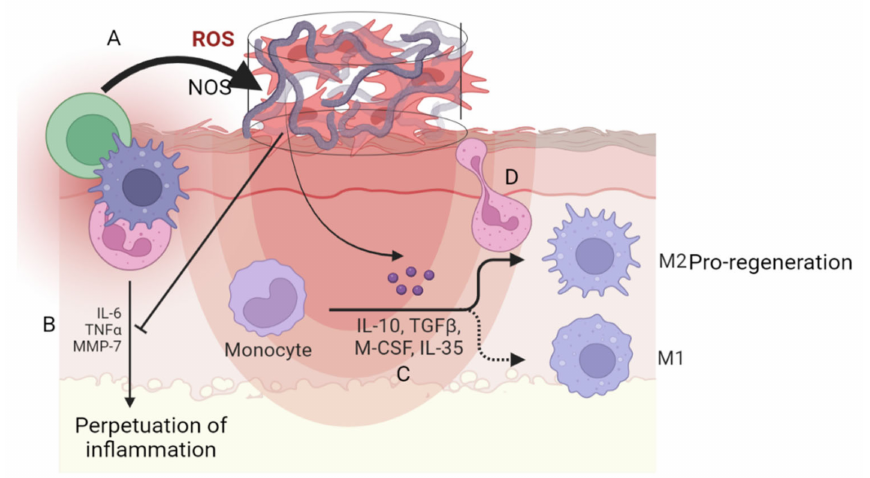
Figure 2. Regulation of the inflammatory response by tissue engineering devices. ( A ) Represents the capacity of biomaterials to scavenge oxidative species. ( B ) The inhibition by MSCs of the pro- inflammatory cytokines. ( C ) The polarization of macrophages towards the M2 phenotype. ( D ) The blockade of immune cell migration (created with BioRender.com, accessed on 30 August